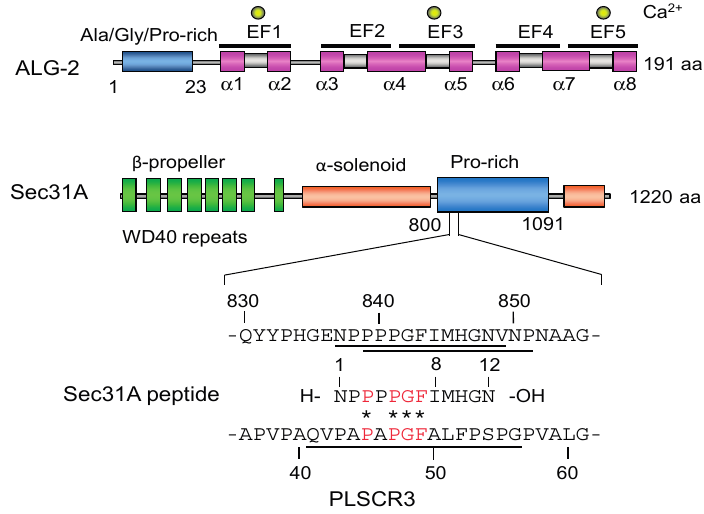
Figure 1. Schematic representation of ALG-2 and Sec31A. ALG-2 has an N -terminal Ala/Gly/Pro-rich flexible region and a penta-EF-hand (PEF) domain containing a unique feature of five EF hands (EF1–5) with eight α -helices ( α 1–8). An N -terminally truncated mutant (des3-20ALG-2) was bacterially expressed and used for crystallization. Calcium ions (Ca 2+ ) bind to EF1, EF3 and EF5 by EF-hand Ca 2+ -coordination. Sec31A contains WD40 repeats and a Pro-rich region. Previously identified ALG-2-binding sites indicated by underlines in Sec31A and PLSCR3 have a conserved P X PGF motif indicated by asterisks and letters in red color [28,29]. A synthetic 12-residue Sec31A peptide was used for co-crystallization with the recombinant des3-20ALG-2